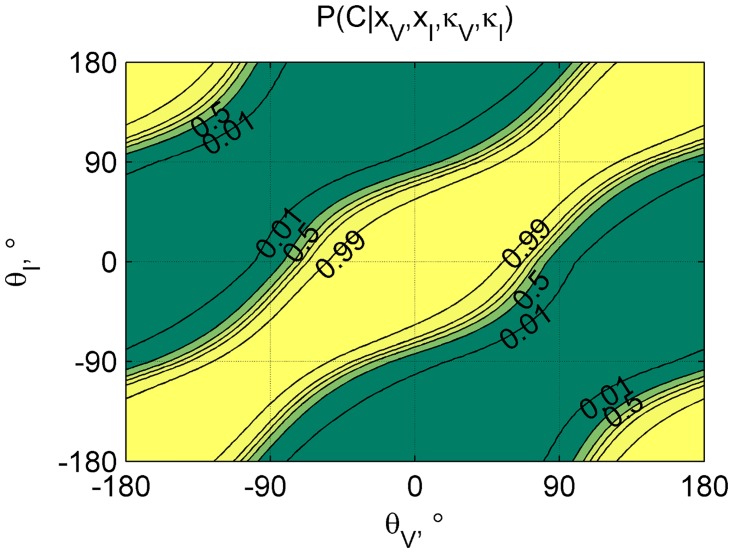
Probability of a common cause.The value of P(C | x
V, x
I, κ
V, κ
I) as a function of θ
V, θ
I; the visual and inertial heading angles, respectively. Values calculated using data of an example participant (7).